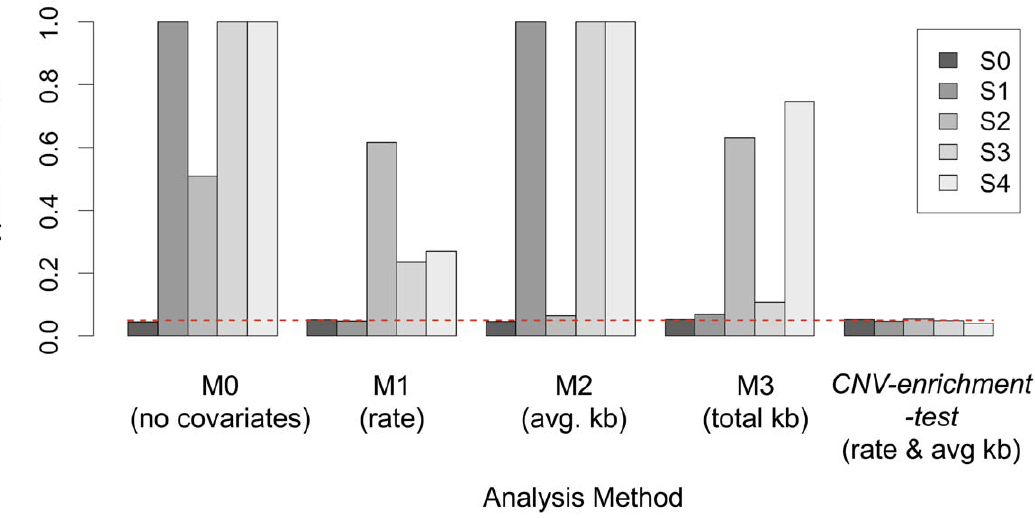
Figure 1. Performance of each of the five proposed models (M0–M4) across five hypothetical scenarios. For each of the scenarios ( S0– S4 ) outlined in Table S2 we simulated 10,000 datasets to calculate the type I error rate for the enrichment test, for a nominal rate of 0.05. Only the model M4 , controlling for CNV rate and average size, obtains an appropriate type I error rate under all scenarios where case-control differences in size and rate are presence. Other models, fail to adequately control for these confounders. The M4 model is presented in the main text as the cnv- enrichment-test .